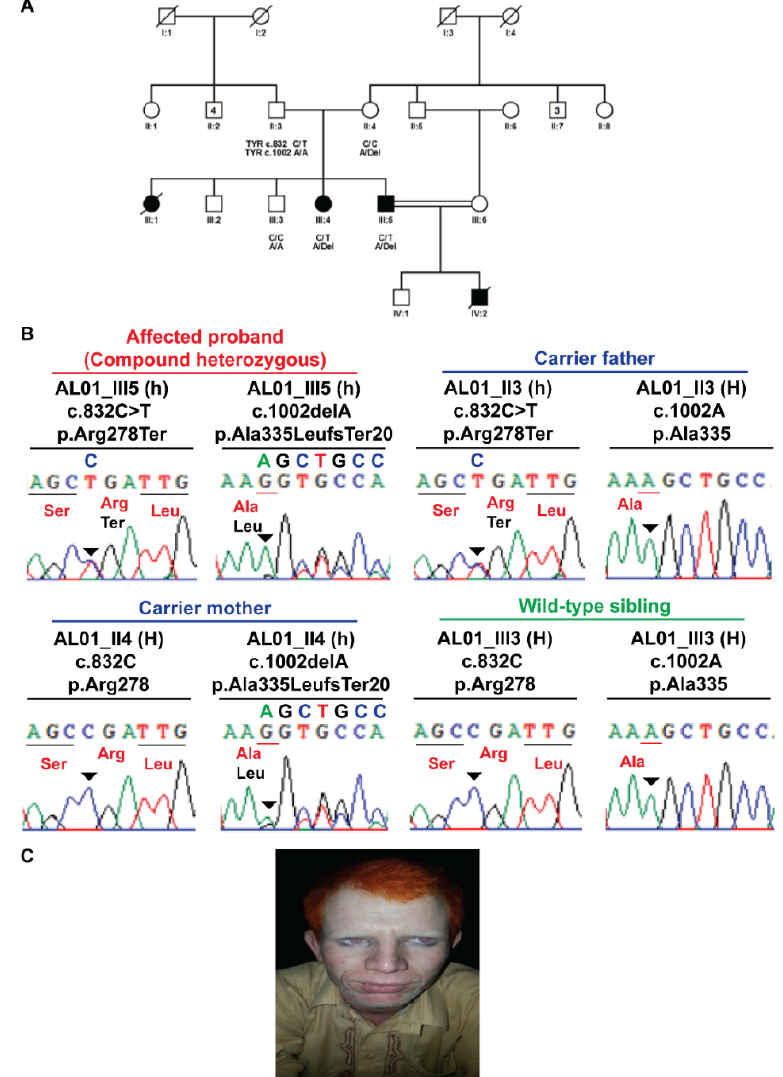
Figure 1. Compound heterozygous TYR p.Arg278Ter and p.Ala335LeufsTer20 variants in AL01 family manifesting albinism. ( A ) Pedigree structure of AL01 family. ( B ) Sanger sequencing electropherograms reflecting familial segregation of TYR p.Arg278Ter and p.Ala335LeufsTer20 pathogenic variants in AL01 family. ( C ) Clinical image depicting clinical features of albinism in pro-band III-5 of family AL01.